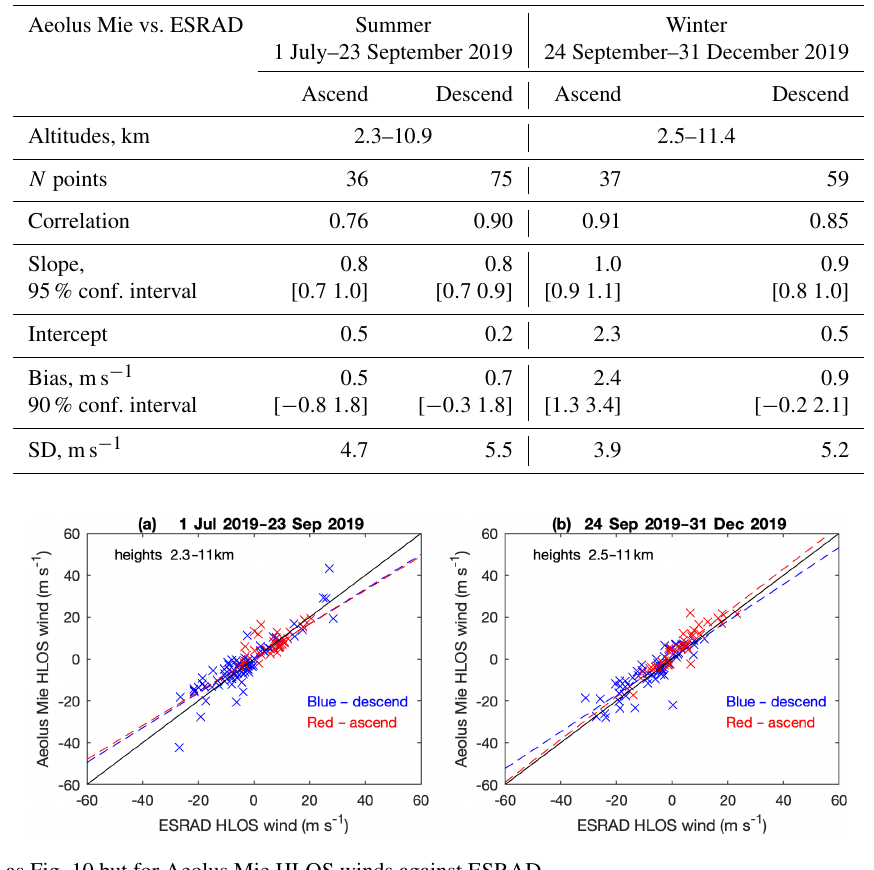
Figure 13. The same as Fig. 10 but for Aeolus Mie HLOS winds against ESRAD.